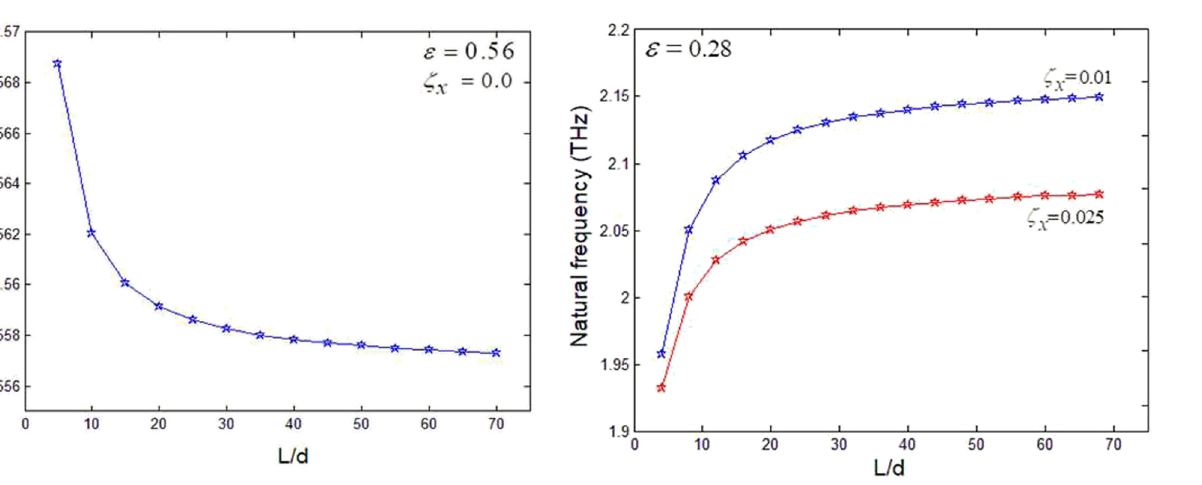
Figure 4: Variations in the natural frequency of irregular ( ε = 0.56 ) single - walled carbon nanotube against aspect ratio ( L / d ) at ( ζ = 0.0 ) .